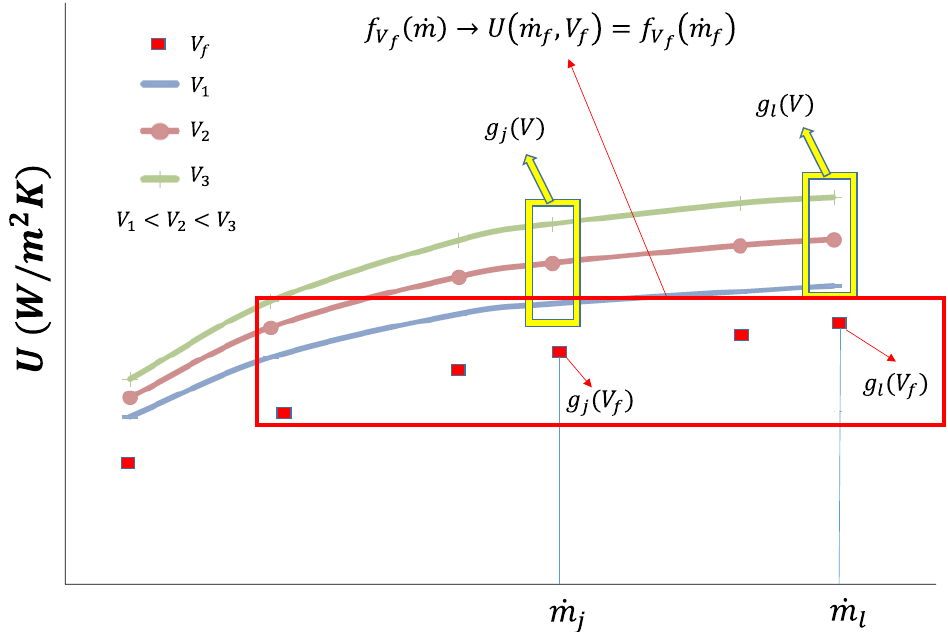
Figure 5. Schematic of the method of obtaining the overall U value from nodal experimental data. For each mean air velocity V j (for j = 1 → l , l is the number of experimental data corresponding to l different configurations of mean air velocity), the functions g j are obtained from k experimental values f i ( i = 1 → k ) (nodal values) using the